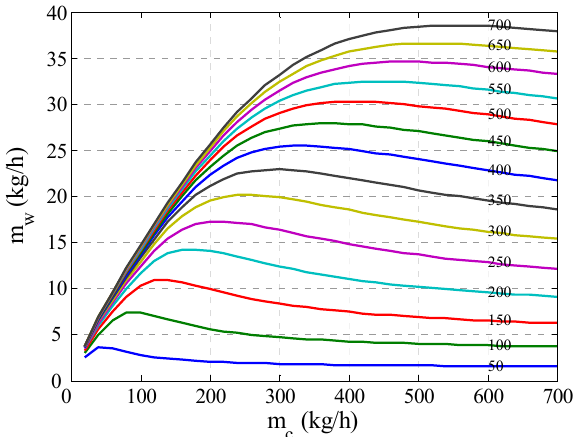
= 80 (cid:2925) C and 𝑇 (cid:3030)(cid:3036)(cid:3041) = = 80 ◦ C and T c = 20 ◦ C. (cid:3284)(cid:3289) in in